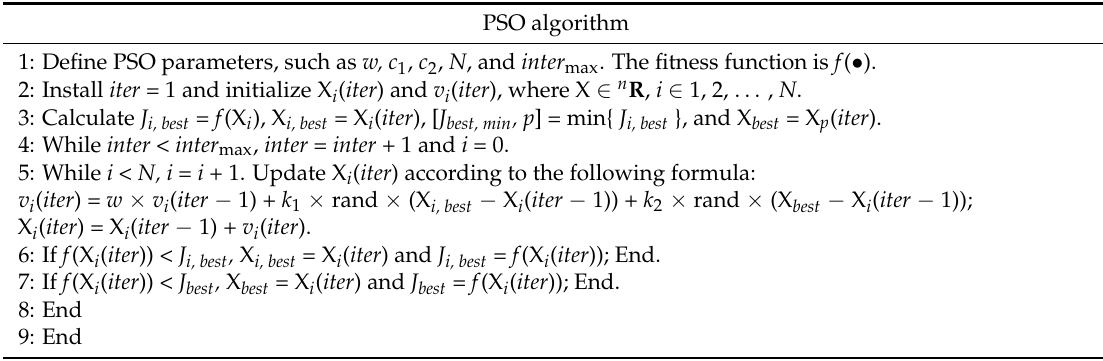
Table 1. Pseudo code of particle swarm optimization (PSO)